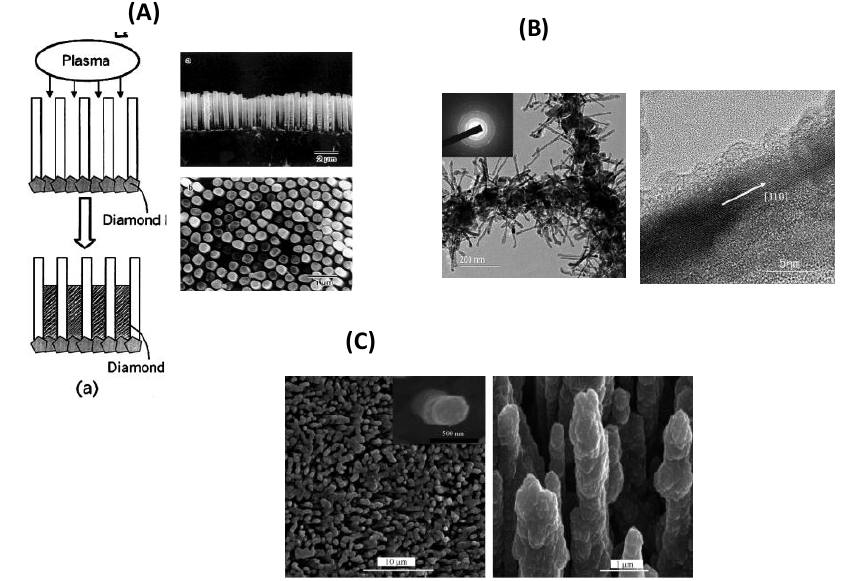
Figure 6. ( A ) Schematic diagram of the bottom-up fabrication of cylindrical diamond wires in porous alumina template ( left ) and the corresponding SEM images (reprint with permission from [28]); ( B ) TEM ( left ) and HR-TEM ( right ) images of diamond rods grown on carbon nanotubes (reprint with permission from [29]); ( C ) SEM image of diamond coated silicon nanowires (reprint with permission from